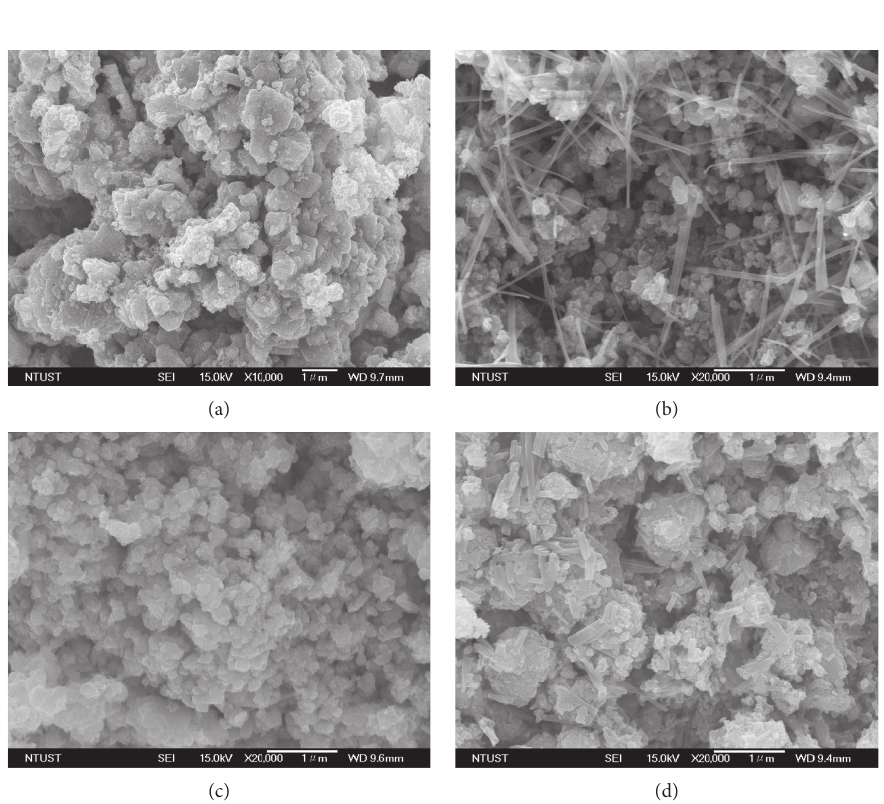
Figure 3: SEM images of (a) 1:1 UZnO, (b) 1:1 ZnO, (c) 3:2 ZnO, and (d) 9:1 ZnO